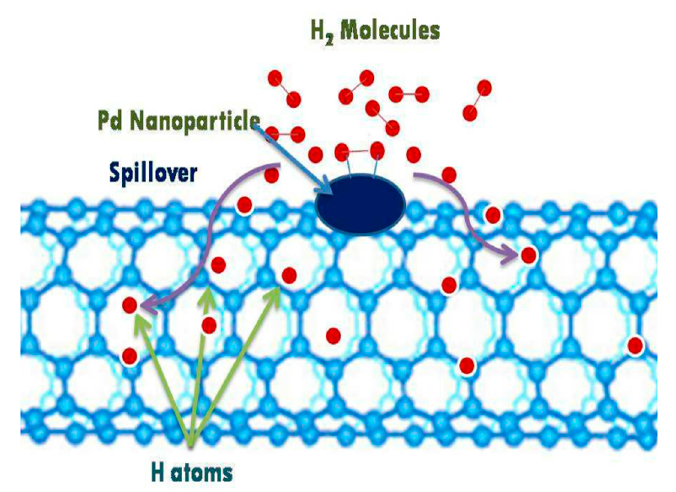
Figure 6. Schematic representation of hydrogen spillover mechanism on Pd dispersed carbon nanotube [130] .